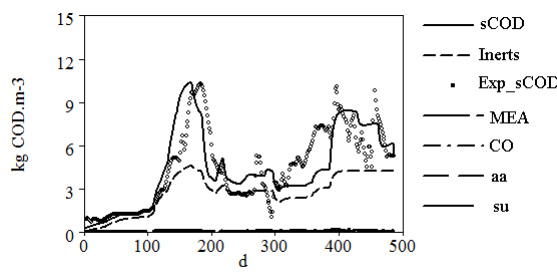
Figure 4: Simulated and experimental effluent com- ponents concentrations (COD based).